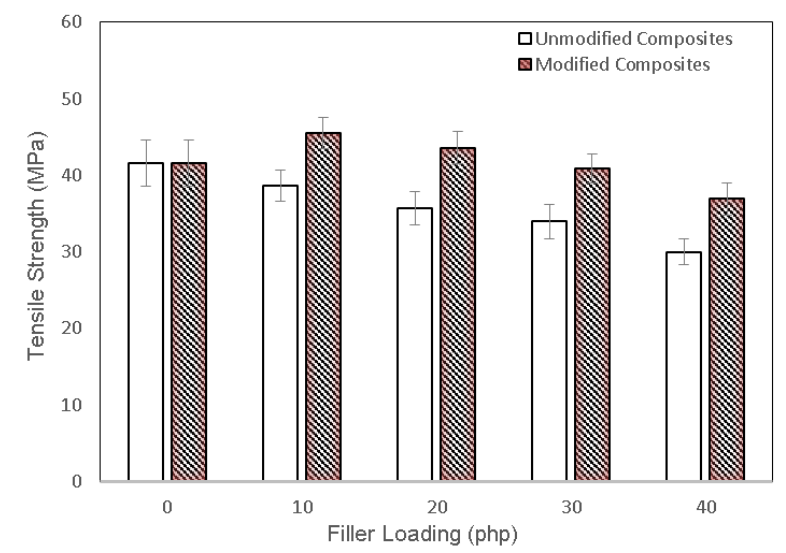
Figure 4. Effect of chitosan content and PAA-g-OSL on tensile strength of PLA/chitosan biocom- posites.